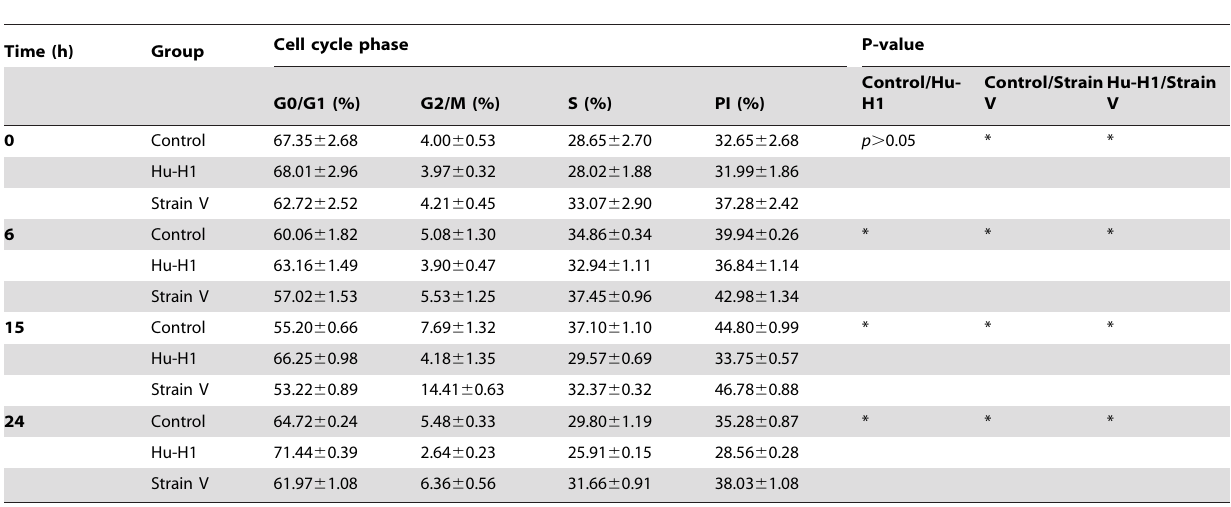
Table 2. Percentages of Hu-H1, Strain V, and control cells at various cell cycle phases (mean 6 s, n =3).